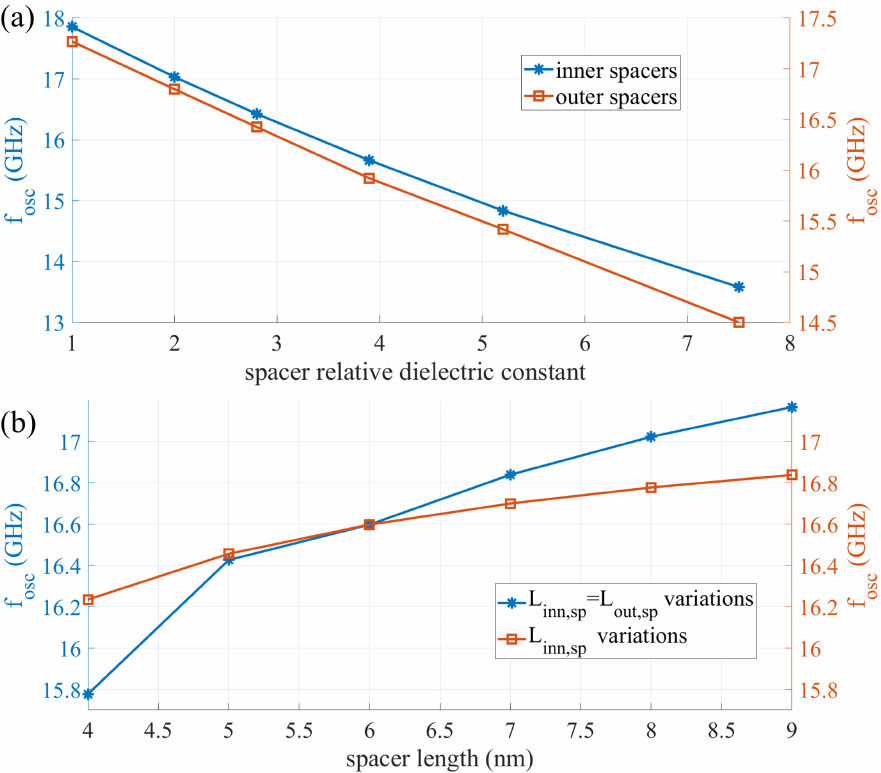
Figure 7. ( a ) Five-stage RO oscillation frequency as function of the inner and outer spacer material dielectric constants—when a dielectric constant is changed, the other is fixed at 3.9. ( b ) Five-stage RO oscillation frequency as function of the inner and outer spacer